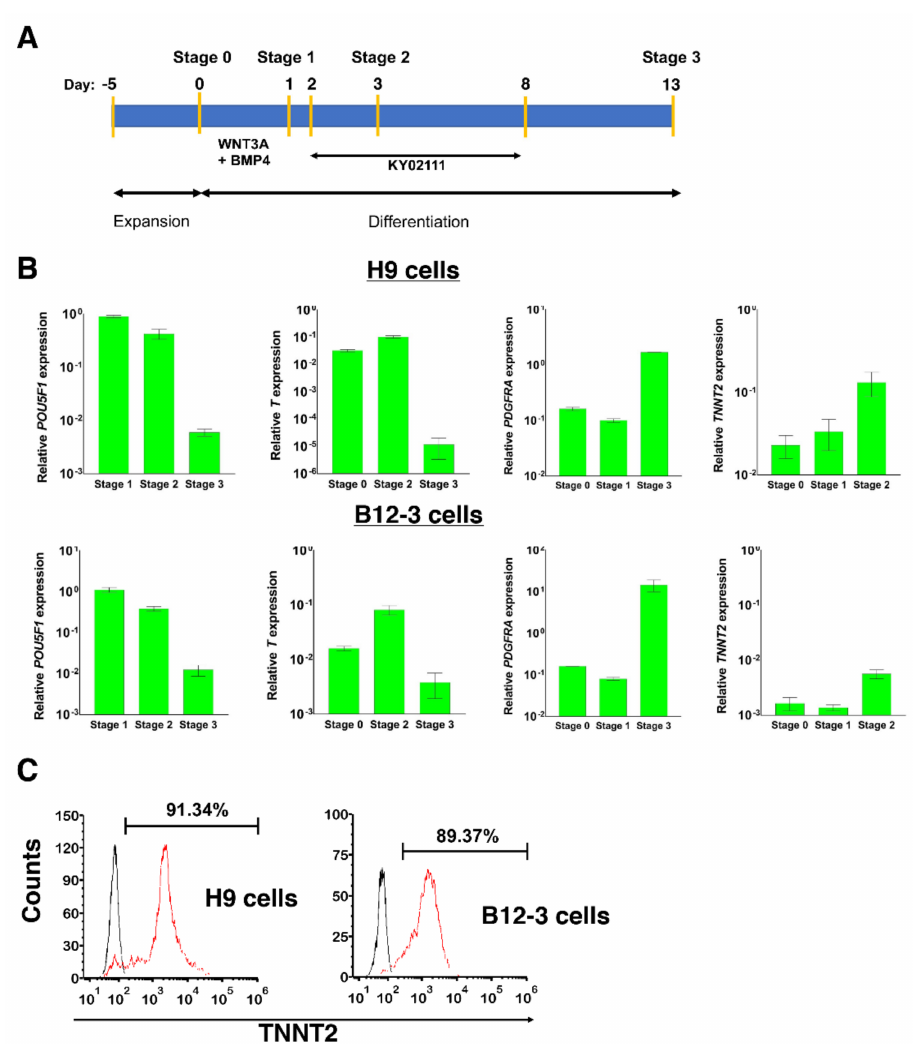
Figure 1. Human PSC differentiation toward CMs. ( A ) Schematic of the protocol implemented for cardiogenic specification of hPSCs. ( B ) Relative gene expression during differentiation assessed by qPCR. Results are shown as mean ± SD ( n = 3) relative to the expression at a specific stage: POU5F1 -stage 0 (S0), T -S1, PDGFRA -S2, TNNT2 -S3. ( C ) Expression of TNNT2 in differentiated hPSCs on day 13 (stage 3). Results from representative flow cytometry runs are shown. Curves: black-Isotype,